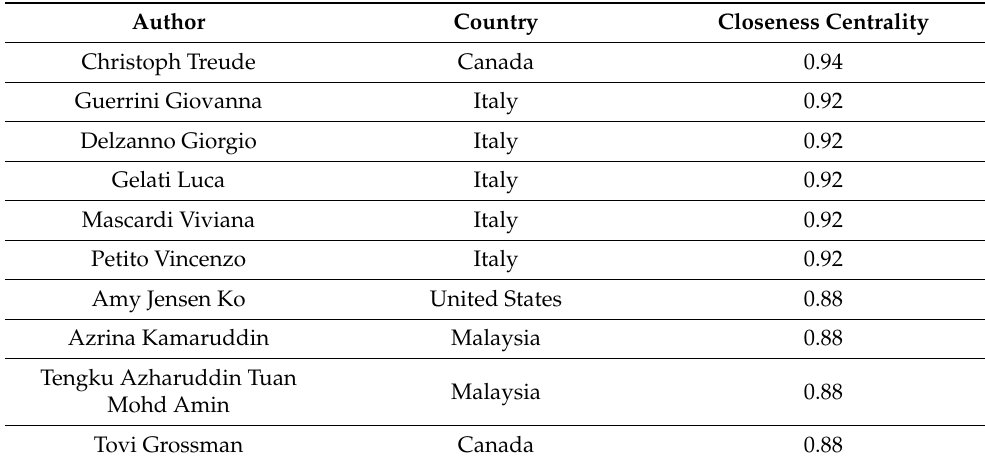
Table 8. Closeness centrality of authors in the CSE co-authorship